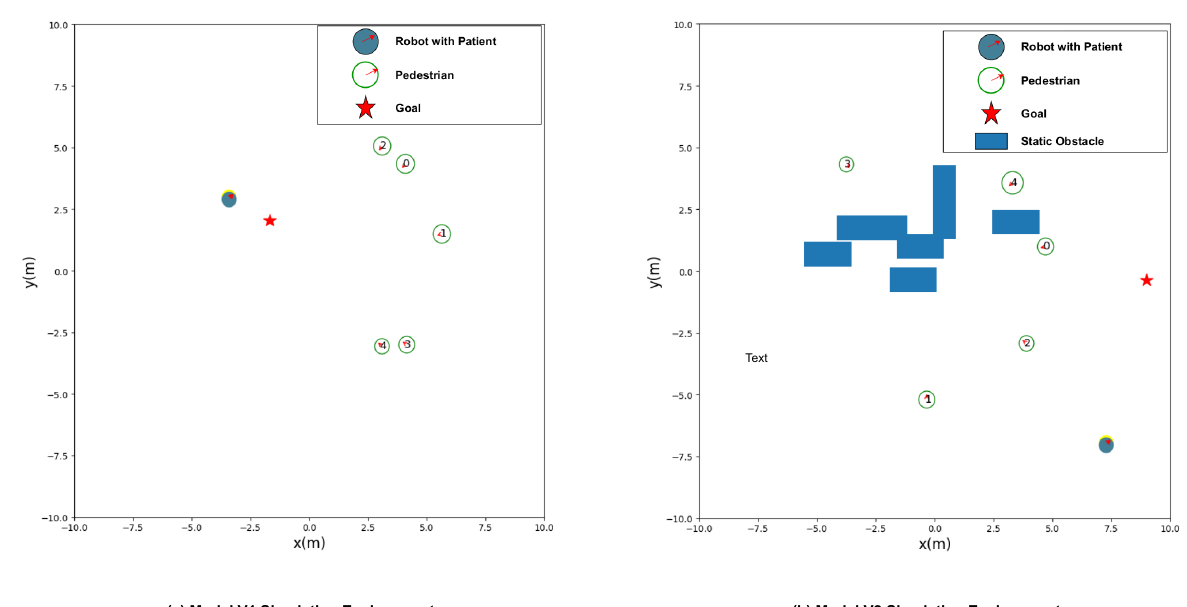
Figure 6. RL simulation environment for the patient–robot co-navigation training.